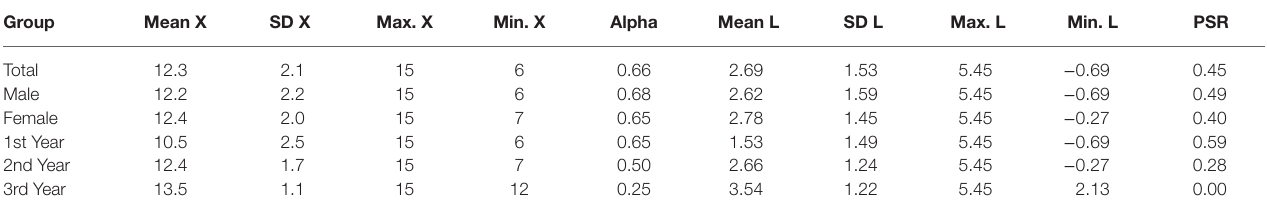
TABLE 5 | Memory. Descriptive statistics of the participants’ scores.